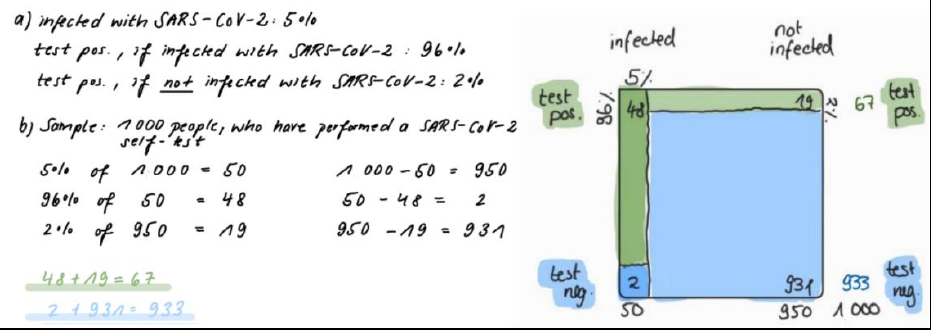
Figure 9. Corrective feedback on the procedural aspect of how to create the visualization.